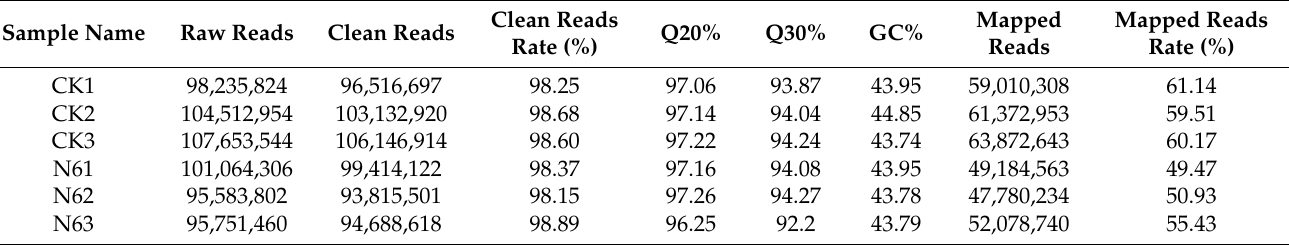
Table 1. Summary of the RNA-seq